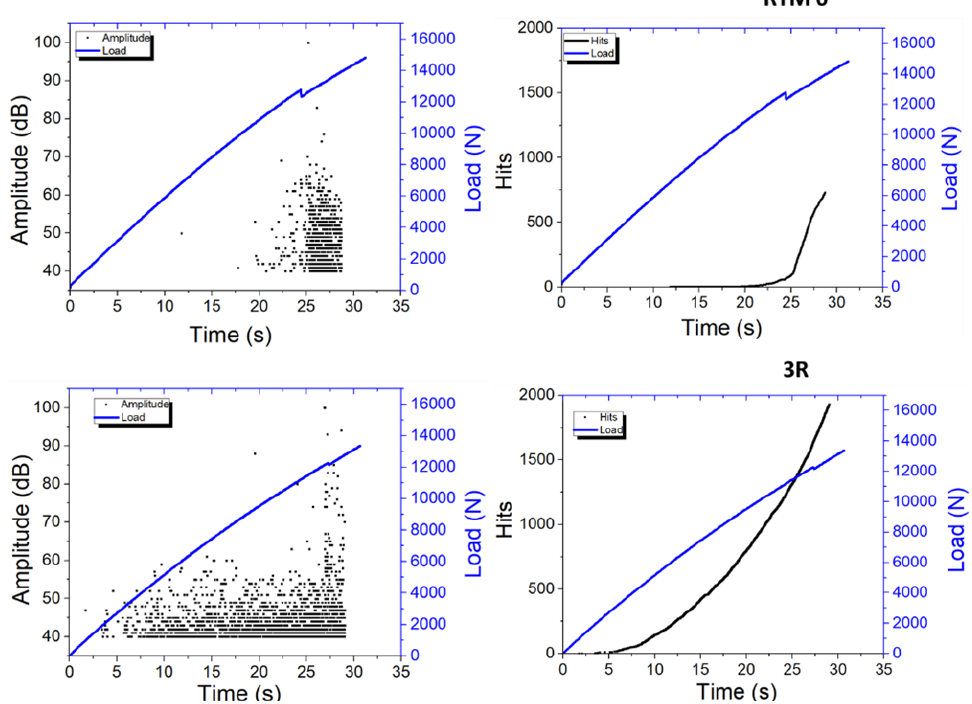
Figure 25. Representative plots of amplitude ( left ) and AE hits ( right ) on RTM6 ( top ) and 3R ( bot- tom ) lap strap